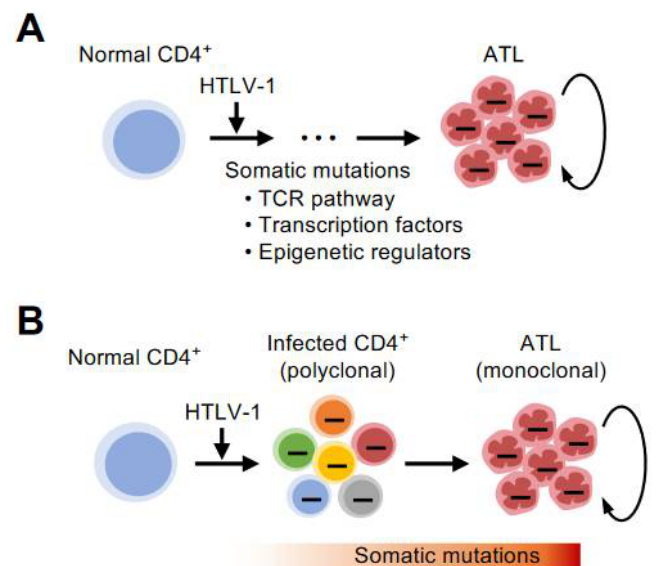
Figure 2. Genetic characteristics in ATL. ( A ) A number of genomic abnormalities are detected in ATL cells. These traces imprinted on the DNA indicate abnormalities necessary for evolution into highly malignant clones. ( B ) Some critical genetic mutations are detected in diverse populations of infected cells before disease onset by deep sequencing. Specific clones are selected to evolve into ATL cells.